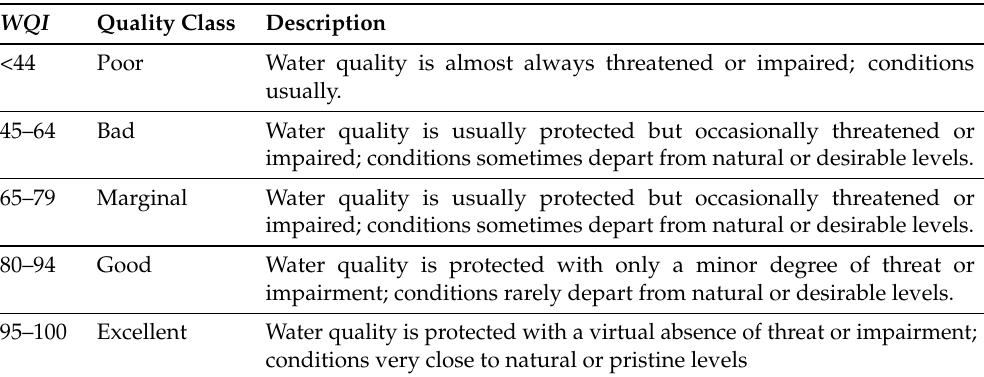
Table A7. Classification of water quality according to Canadian Council of Ministers of the Environment (CCME) method